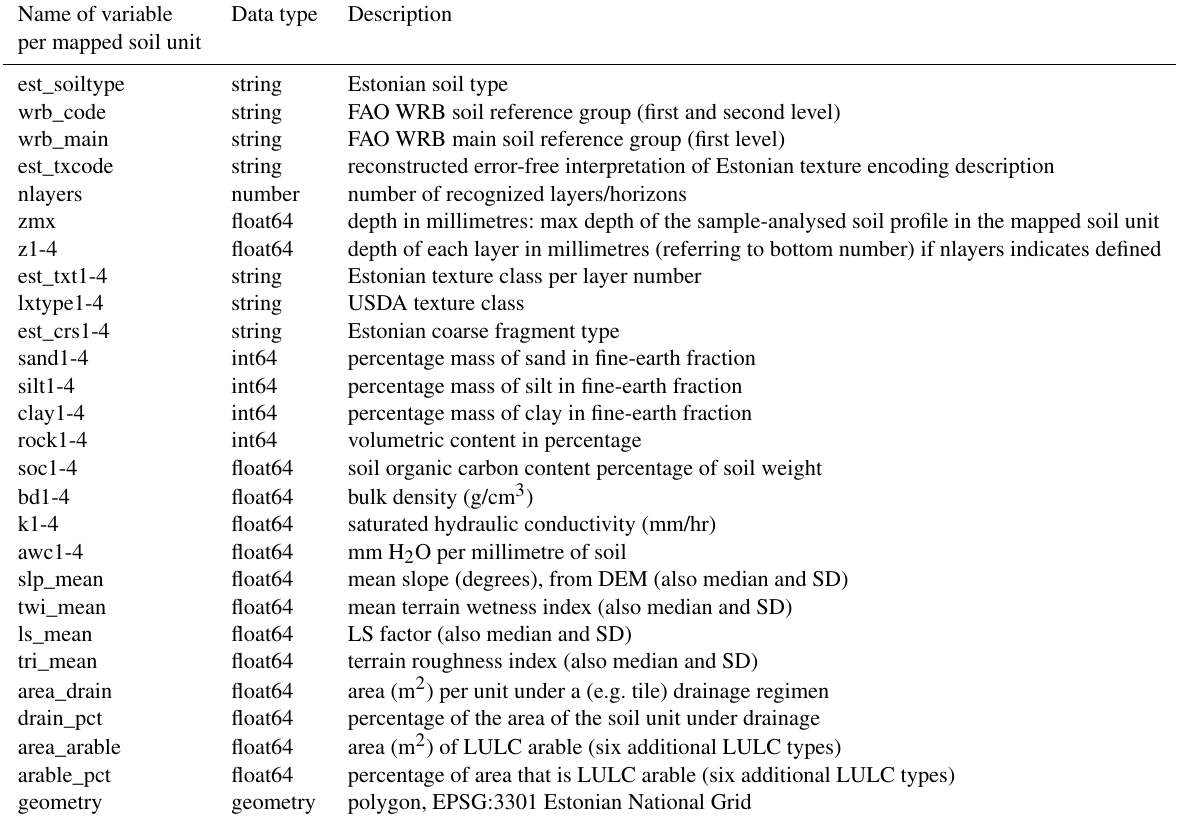
Table 3. Description of variables and parameters available in the EstSoil-EH